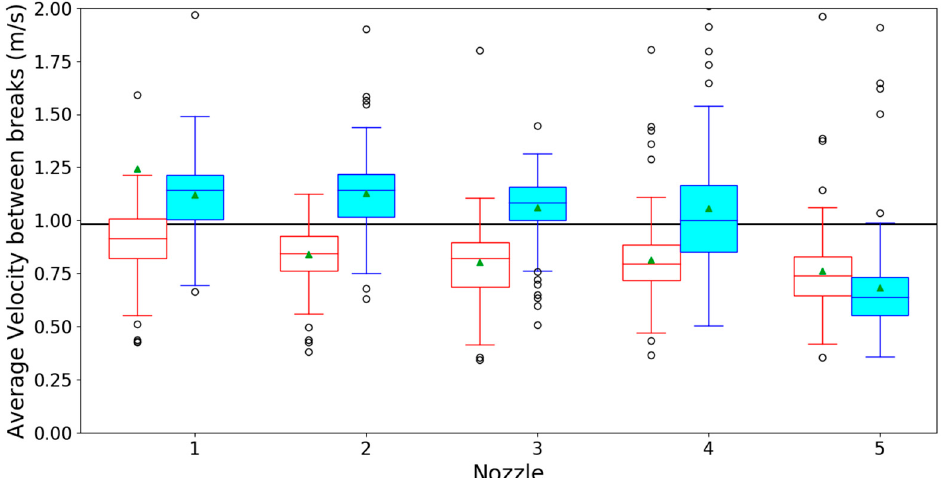
Figure A1. Boxplot graphs of the average liquid velocities in the experiments done with 6 L · min − 1 for the regular (red boxes) and vortex (blue boxes) showerhead and nozzles 1 (outermost) to 5 (innermost). The green triangles are the calculated population mean. The horizontal black line is the expected liquid velocity calculated using continuity law [15] by taking the flow rate divided by the total nozzle surface area.